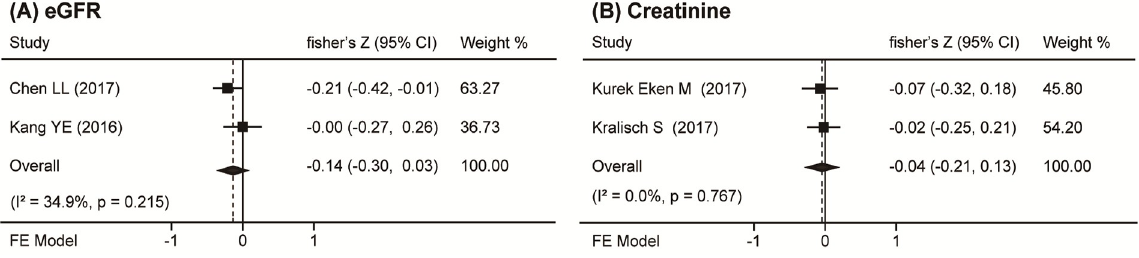
Fig 4. Forest plot of the association between circulation Nrg4 levels and renal function markers in DM. Summaries are shown of the association circulation Nrg4 levels and (A) eGFR and (B)